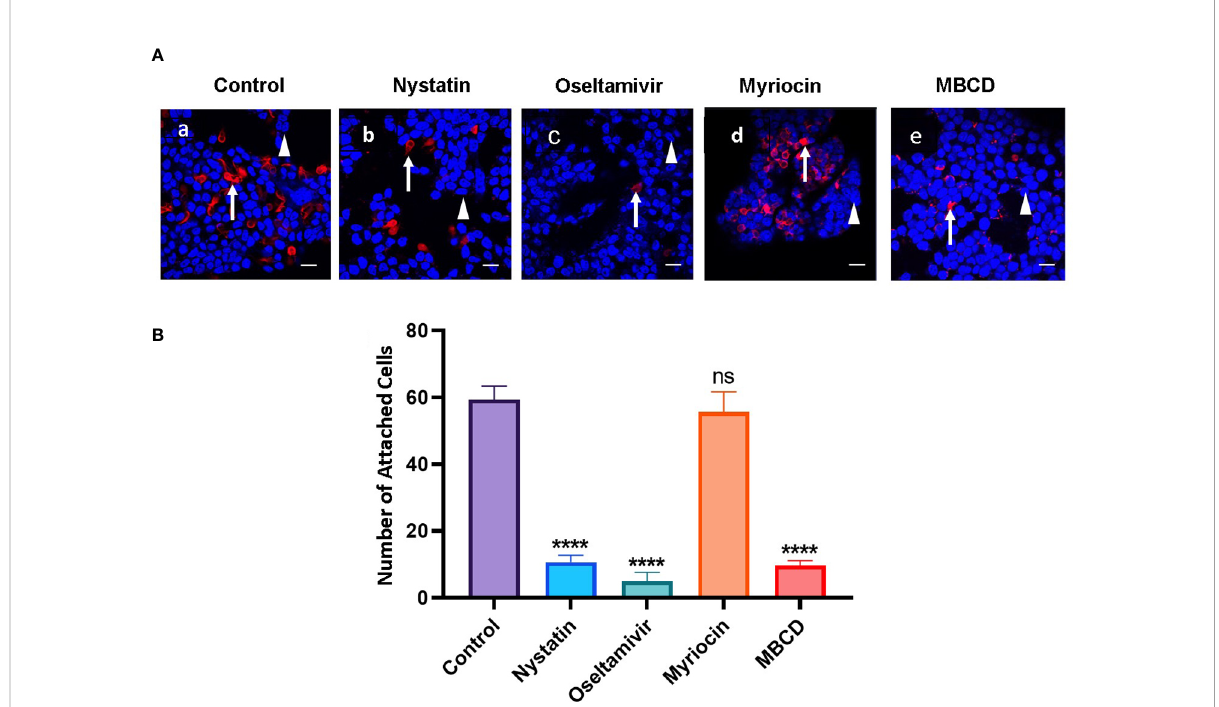
FIGURE 3 Raft inhibitors block the attachment of trophozoites to HT29 cells. (A) Trophozoites were incubated for 30 min at 37°C in the presence of nystatin (27 m M), oseltamivir (20 m M), myriocin (20 m M) and MBCD (1mM) as described in Materials and Methods. Treated trophozoites were collected, washed in PBS, counted, and added to a con fl uent monolayer of HT29 cells. The Giardia and HT29 cells were co-incubated in serum-free McCoy ’ s medium (pH, 7.4) for 3 h at 37°C. After removing the McCoy ’ s medium, co-cultured cells (HT29 and trophozoites) were fi xed, labeled with antibodies against a major surface protein of Giardia (TSA 417) conjugated to Alexa Fluor 568) (Gillin et al., 1990), stained with DAPI (to identify the nucleus of HT29 cells), and analyzed by were captured with the help of a confocal microscope (Carl Zeiss LSM 700) and analyzed by Zen 2009 software. Arrow indicates trophozoites (red) and arrowhead shows the DNA of HT29 cells (blue). Bar: 2 m m. (B) For quantitation, attached trophozoites (red) were counted to observe the effects inhibitors. Approximately, 50-100 co-cultured cells were examined from 5-10 different fi elds to identify attached cells. The results were presented in mean values of attached cells ± SD of three separate experiments conducted in different days with different samples preparations. ****P<0.001; ns, not signi fi